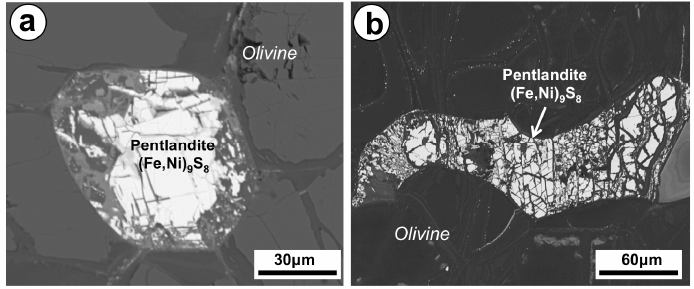
Figure 7. ( a , b ) Backscattered electron images of pentlandite grains in peridotites hosting the North Andaman chromitites.